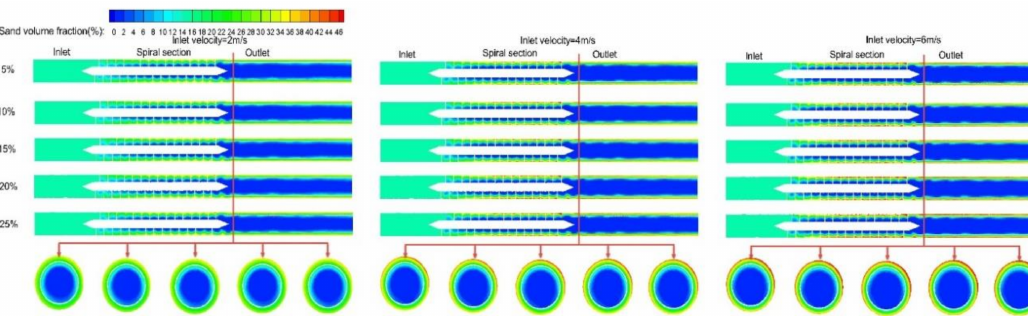
Figure 9. NGH distribution contours across the horizontal section of the spiral separator and the vertical section at the outlet with di ff erent inlet NGH volume fraction.